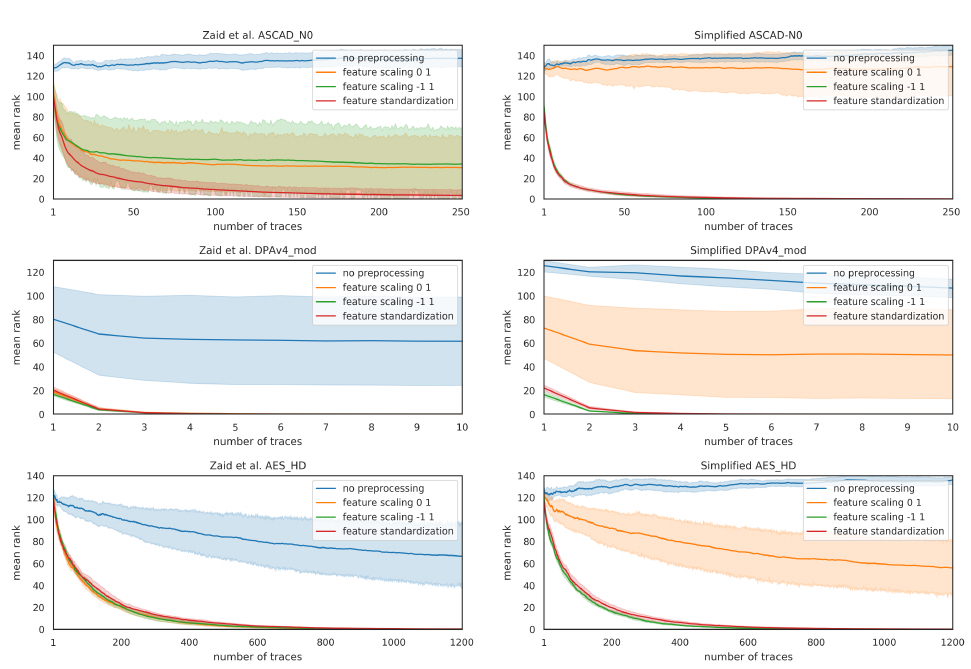
Figure 1: Each plot shows the evolution of the average rank of the correct key hypothesis over the number of traces used for the attack. For each model we performed 100 attacks on random subsets of the attack set. The error bands indicate the difference between multiple experiments on different splits of the profiling dataset. Comparison between the models proposed by Zaid et al. (left) and those same models without the first convolutional layer (right). The models are trained on the aligned datasets using different preprocessing